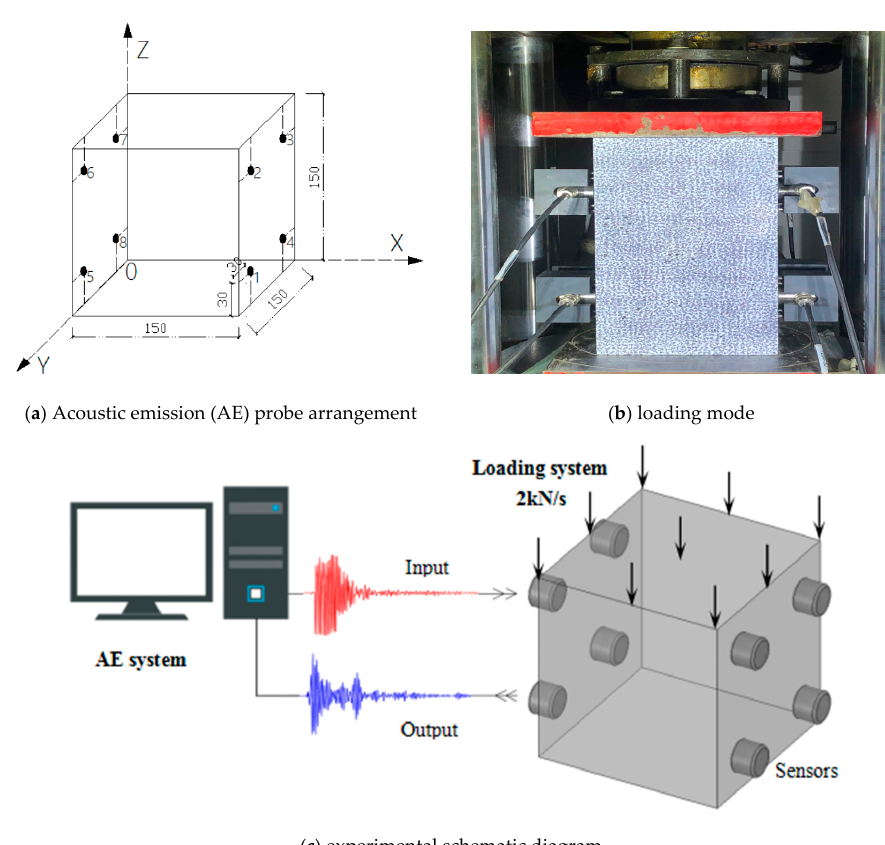
Figure 2. Acoustic emission (AE) probe arrangement and experimental schematic diagram. (Unit: mm).